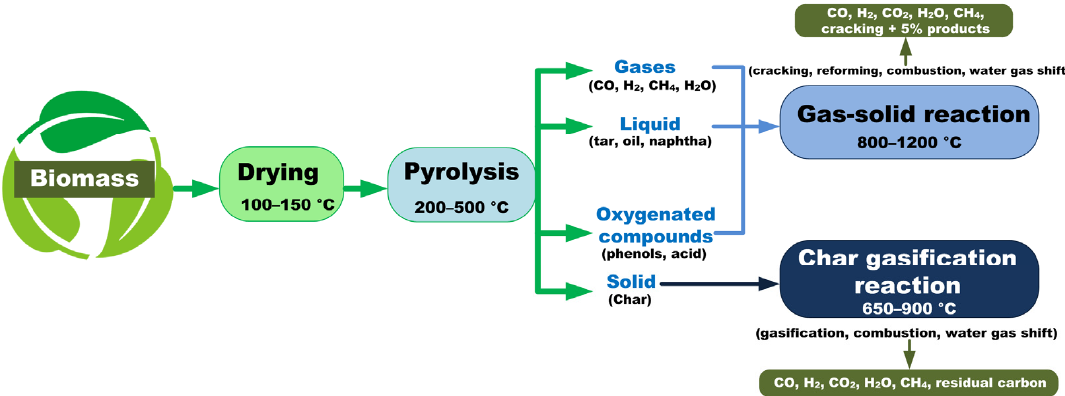
Figure 1. Mechanisms and stages of pyrolysis and gasification.